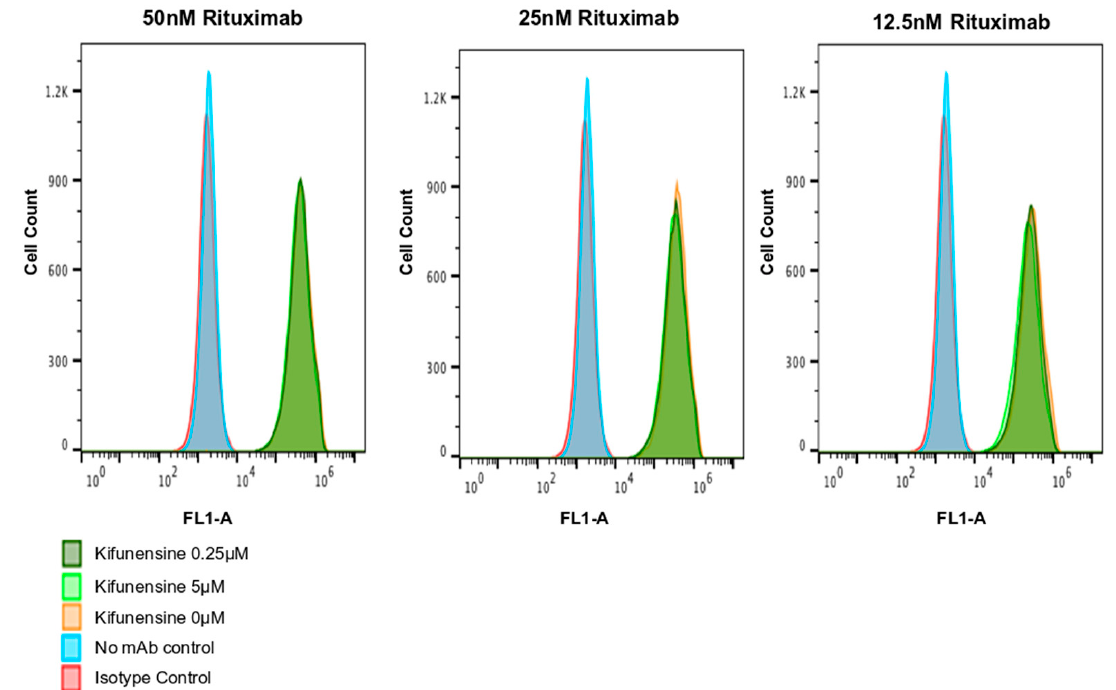
Figure 4. CD20 binding assay of rituximab treated with kifunensine 5 µM, 0.25 µM and untreated controls with Flow Cytometry analysis. Plant-made rituximab was used at concentrations of 50 nM, 25 nM and 12.5 nM. Antibodies bound to CD20 on Wil2-S were detected with goat anti-human IgG polyclonal antibodies conjugated with Fluorescein isothiocyanate (FITC). Median Fluorescence intensity (MFI) was derived from the median value of the fluorescence histogram.